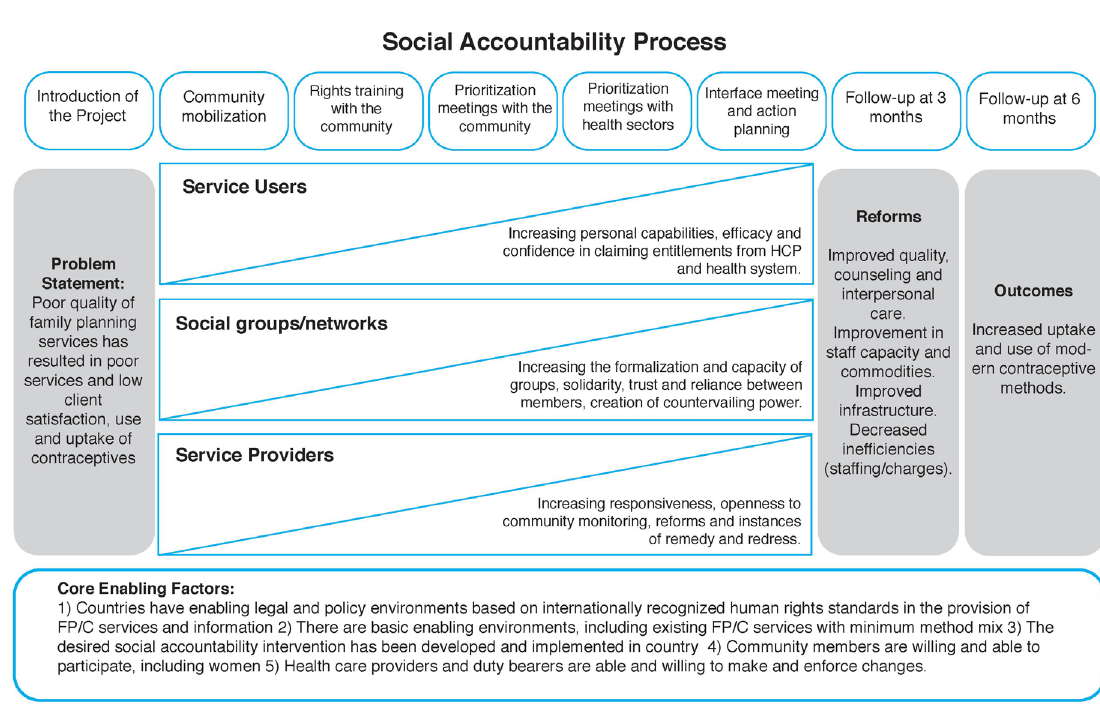
Figure 1. CaPSAI Project theory of